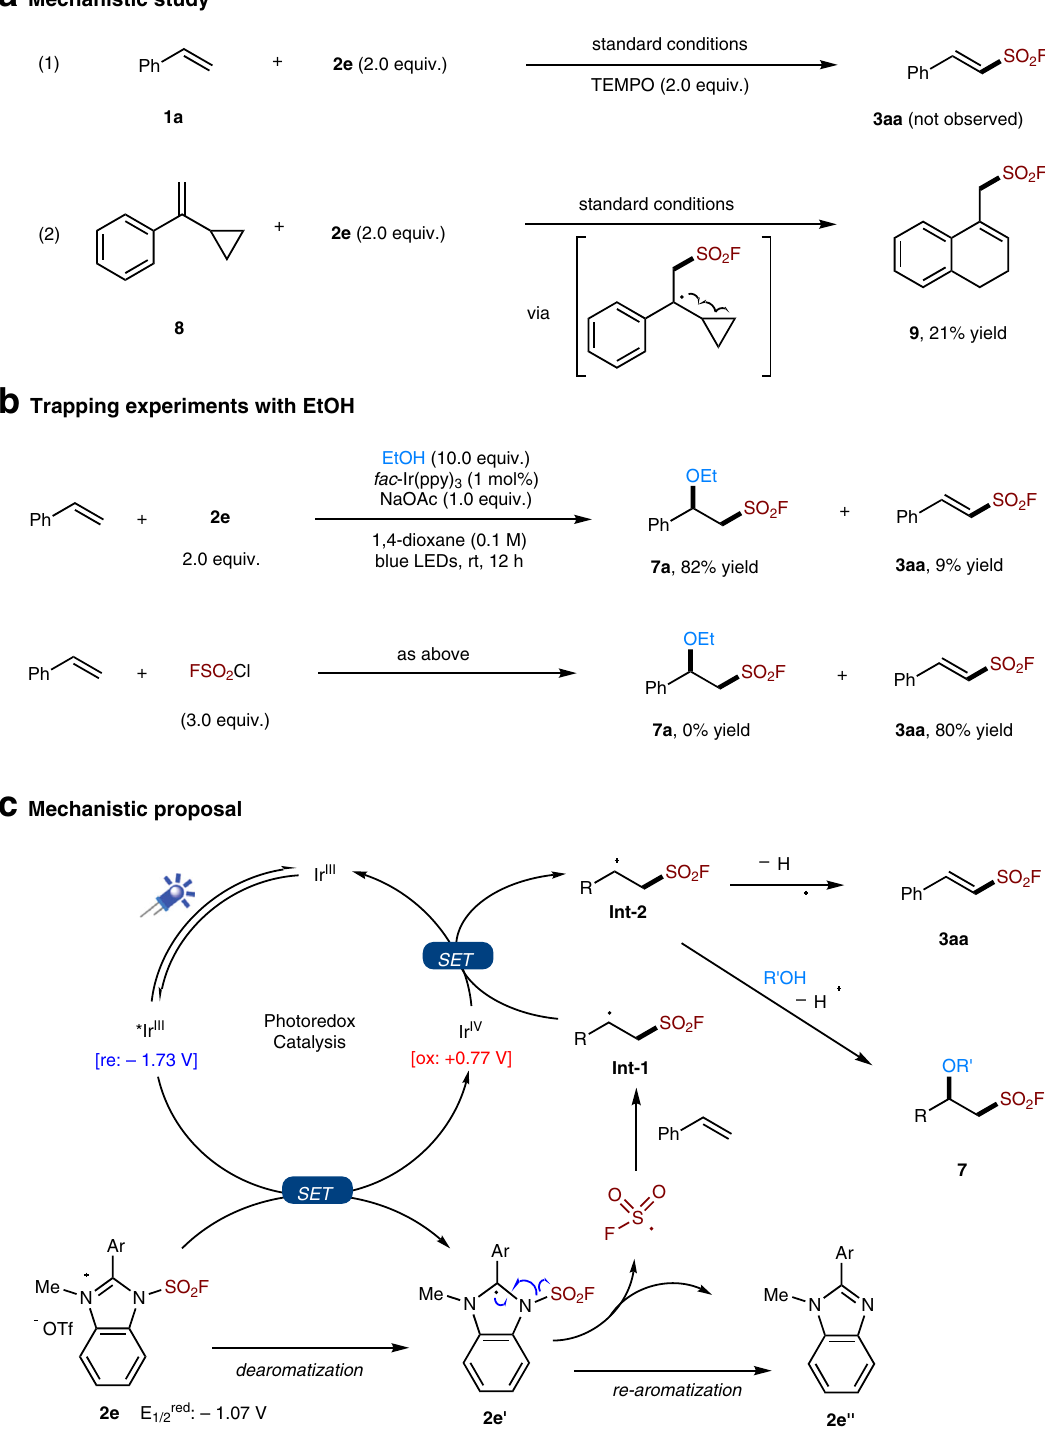
Fig. 6 Mechanistic study and proposal. a Mechanistic study: (1) the reaction was performed under standard conditions with TEMPO (2.0 equiv.); (2) the reaction was performed under standard conditions with 8 as a radical probe. b Trapping experiments was performed with styrene (0.1 mmol), radical precursor (2.0 – 3.0 equiv.), EtOH (10.0 equiv.), fac -Ir(ppy) 3 (1 mol%), NaOAc (0.1 mmol), and 1,4-dioxane (1 mL) under the irradiation of 6 W blue